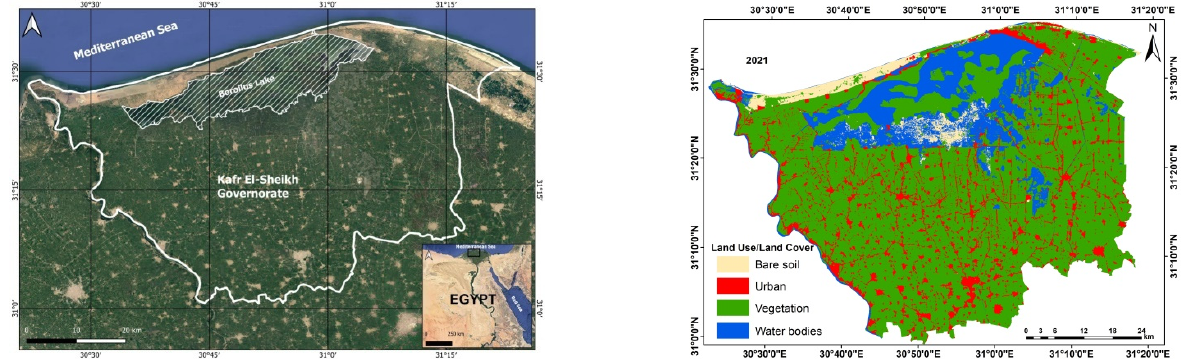
Figure 1. Location of Kafr El-Sheikh Governorate area and land use/land cover units.